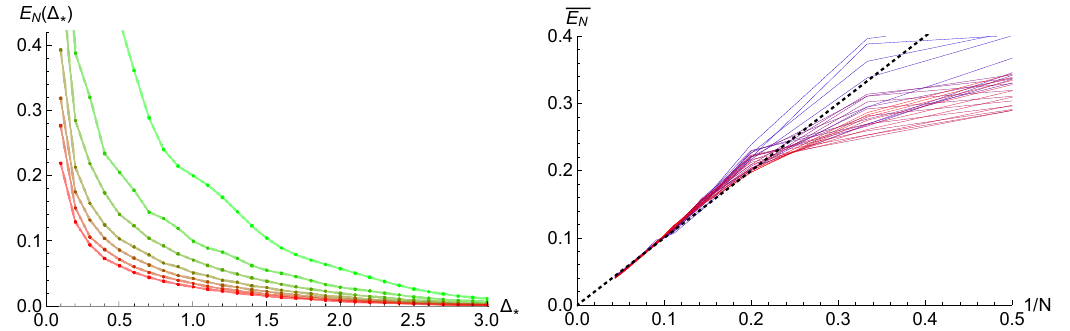
Figure 14 . Plots of approximation errors for n + m odd. Left : E N as a function of (cid:1) (cid:3) for N from 5 (green) to 29 (red) in steps of 4. Right : normalized E N as a function of N (cid:0) 1 for (cid:1) (cid:3) from 0 : 4 (blue) to 1 : 5 (red). The dashed black line is shown for comparison and has slope